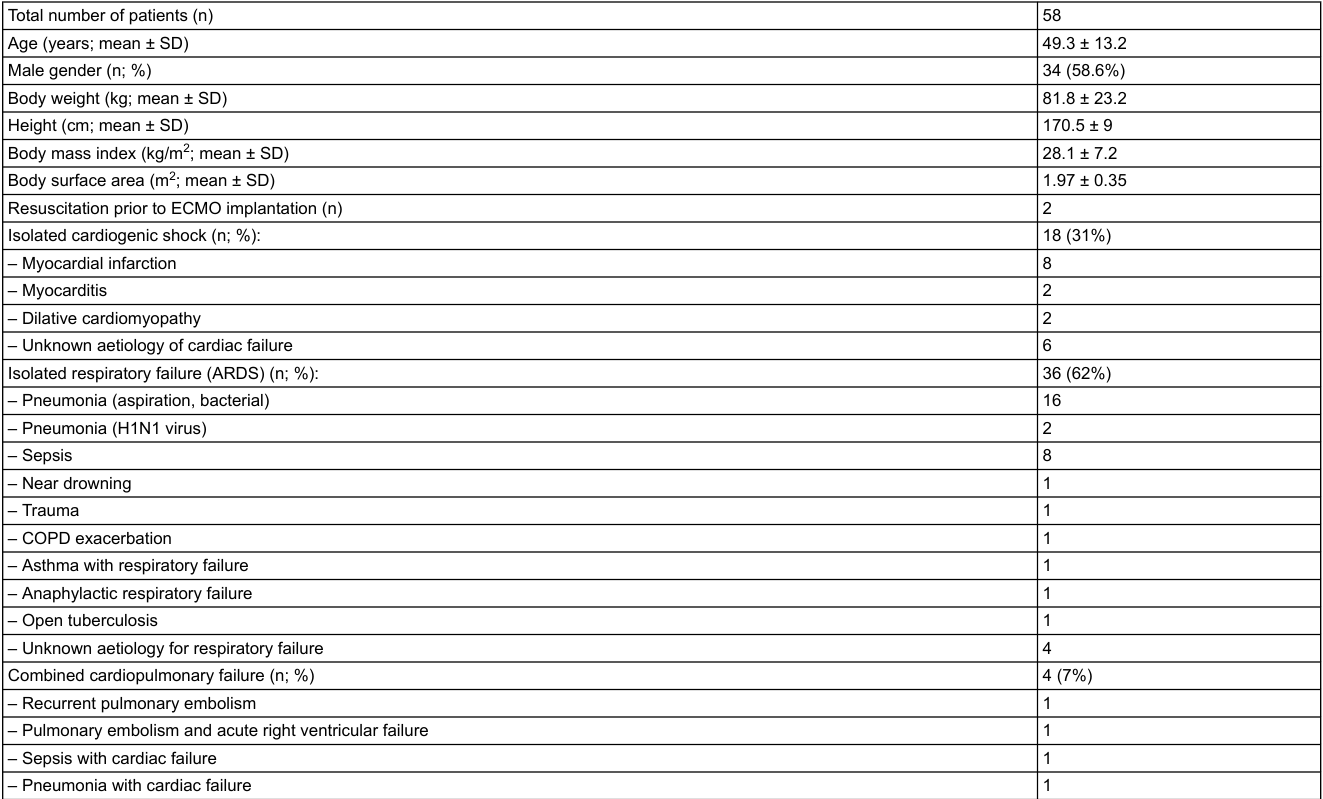
Table 1: Demographic data of study population. Total number of patients